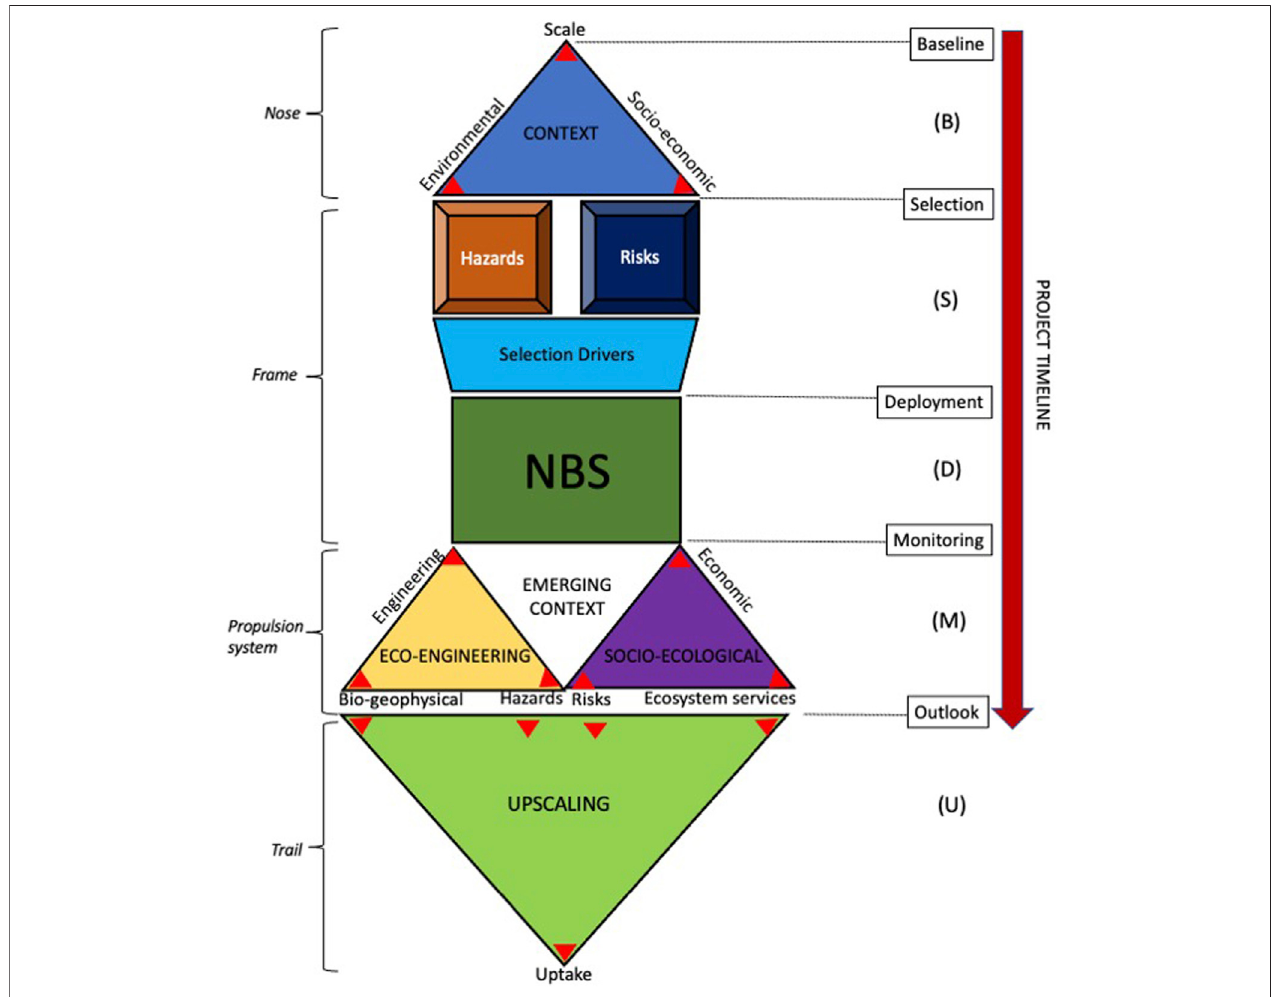
FIGURE 2 | The ‘ rocket framework ’ strives to facilitate the operationalisation of NBS actions against landslides and erosion by helping to articulate the thinking process involved in the identi fi cation of multi-functional key performance indicators at different stages of the NBS project -i.e., baseline establishment (B), NBS selection (S), deployment (D), and monitoring(M), whichis thestage in which NBS performanceagainst landsldies and erosion is envisaged tobe essentially assessed. The vision of the ‘ rocket framework ’ is to ‘ uplift ’ the acceptance and reproduction of NBS actions through facilitating the provision of a strong evidence base on their performance. The ‘ rocket framework ’ is inspired in the illustration of spatial rockets (e.g., https://www.grc.nasa.gov/www/k-12/rocket/rockpart.html) to make it easy to memorise thedimensionsand compartments that should beconsidered in theprocess ofmonitoring NBSagainst landslides and erosion. The capital letters in brackets help identify the project stage for the indicators provided in the repositories in Table 1 and Supplementary Material .